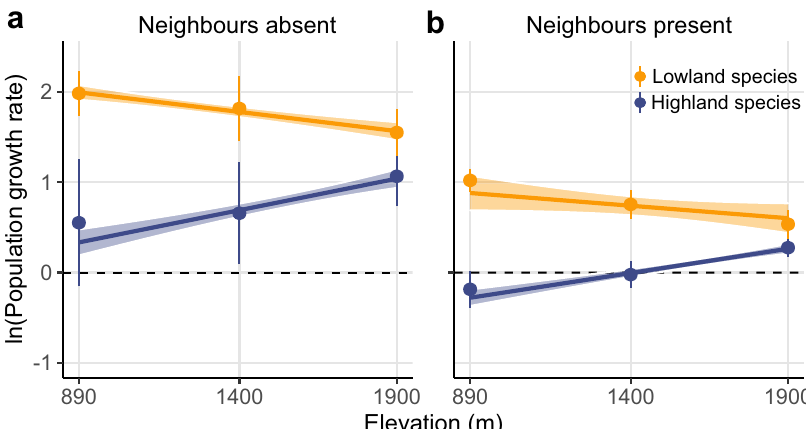
Fig. 1 Population growth rates across the elevation gradient. Population growth rates ( λ ) of lowland (orange) and highland (blue) species across the elevation gradient when neighbours are absent ( a ; n = 7 at each elevation for lowland species, n = 6, 7, and 7 for highland species at the low, middle, and high elevations, respectively) and present ( b ; n = 51, 51, and 56 for lowland species, and n = 40, 48, and 54 for highland species at the low, middle, and high elevations, respectively). Populations are predicted to persist when ln( λ ) > 0 (dashed horizontal line). The points and error bars represent the averages and standard errors across species at each site. Solid lines show signi fi cant relationships (test based on the mean of 500 bootstrap replicates; P < 0.05; Supplementary Table 4). Shading indicates 95% con fi dence intervals for the regressions derived from bootstrap replicates of the dataset ( N = 500 bootstraps), indicating the propagated uncertainty in the relationships resulting from model parametrization (see Methods). Source data are provided as a Source Data fi